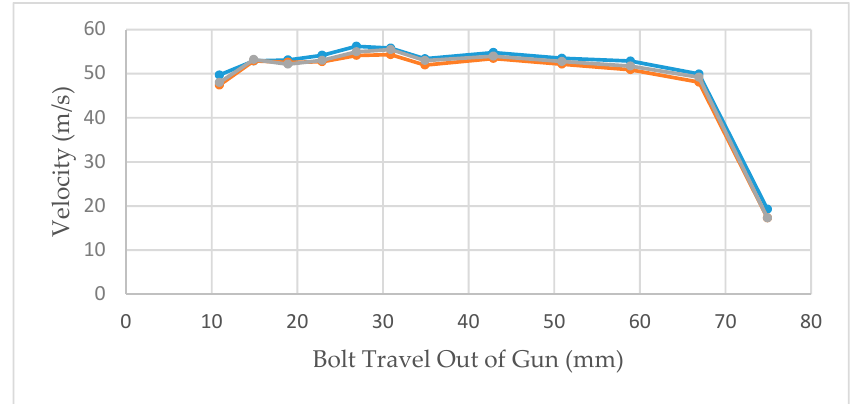
Figure 11. Bolt velocities recorded by the velocimeter at the different measurement points; 3 shots using 3.50 grain cartridges.